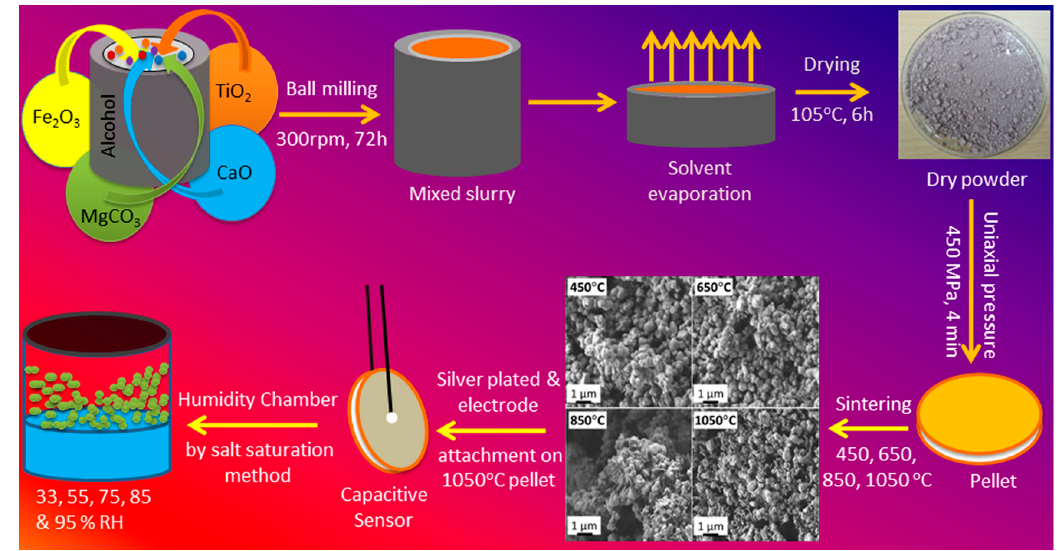
Figure 1. Flow chart for sensor fabrication with the morphology at different sintering temperature.